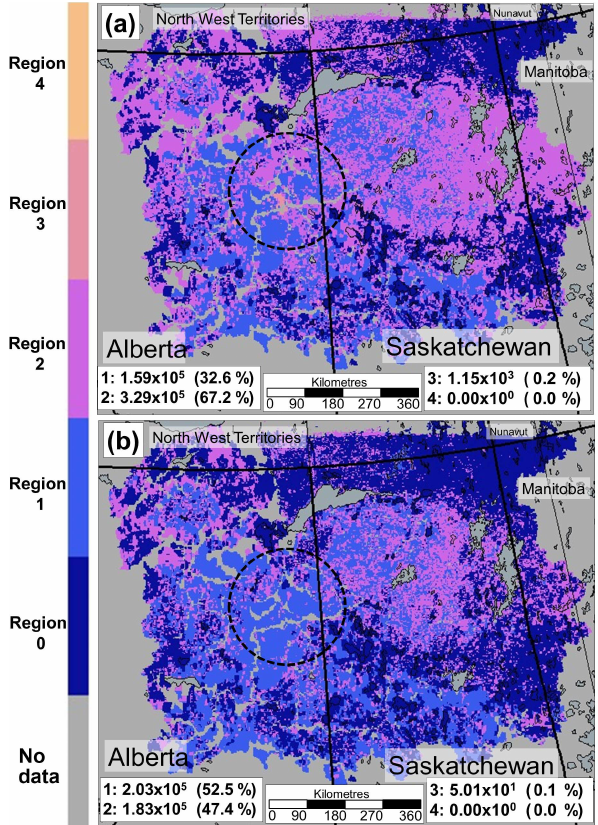
Figure 19. Predicted aquatic ecosystem critical load exceedances with respect to sulfur and nitrogen deposition, (eqha − 1 yr − 1 ). Boxed numbers are the area in exceedance and the percent of the to- tal area for which critical loads are available which is in exceedance. (a) Calculated using original model sulfur and nitrogen deposition. (b) Calculated using model sulfur and nitrogen deposition corrected to match precipitation observations. Circled region: 140km radius diameter circle around the Athabasca oil sands.